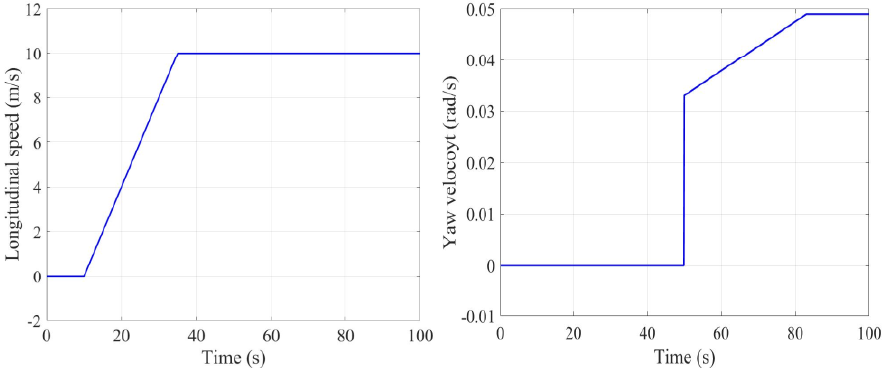
Figure 13. Simulation driving conditions including the longitudinal speed and yaw velocity.